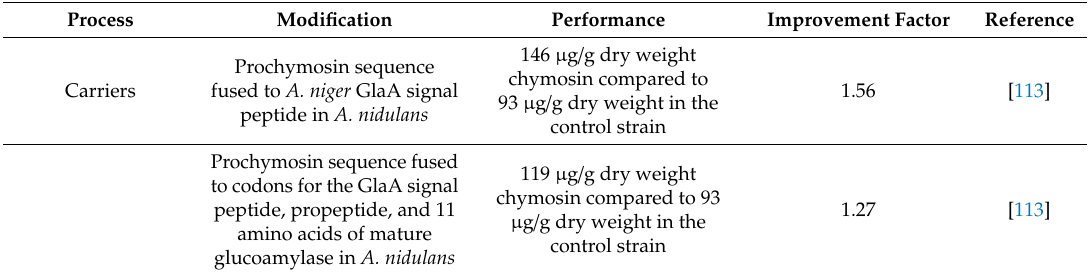
Table 9. Approaches for improving recombinant protein production through the use of carrier